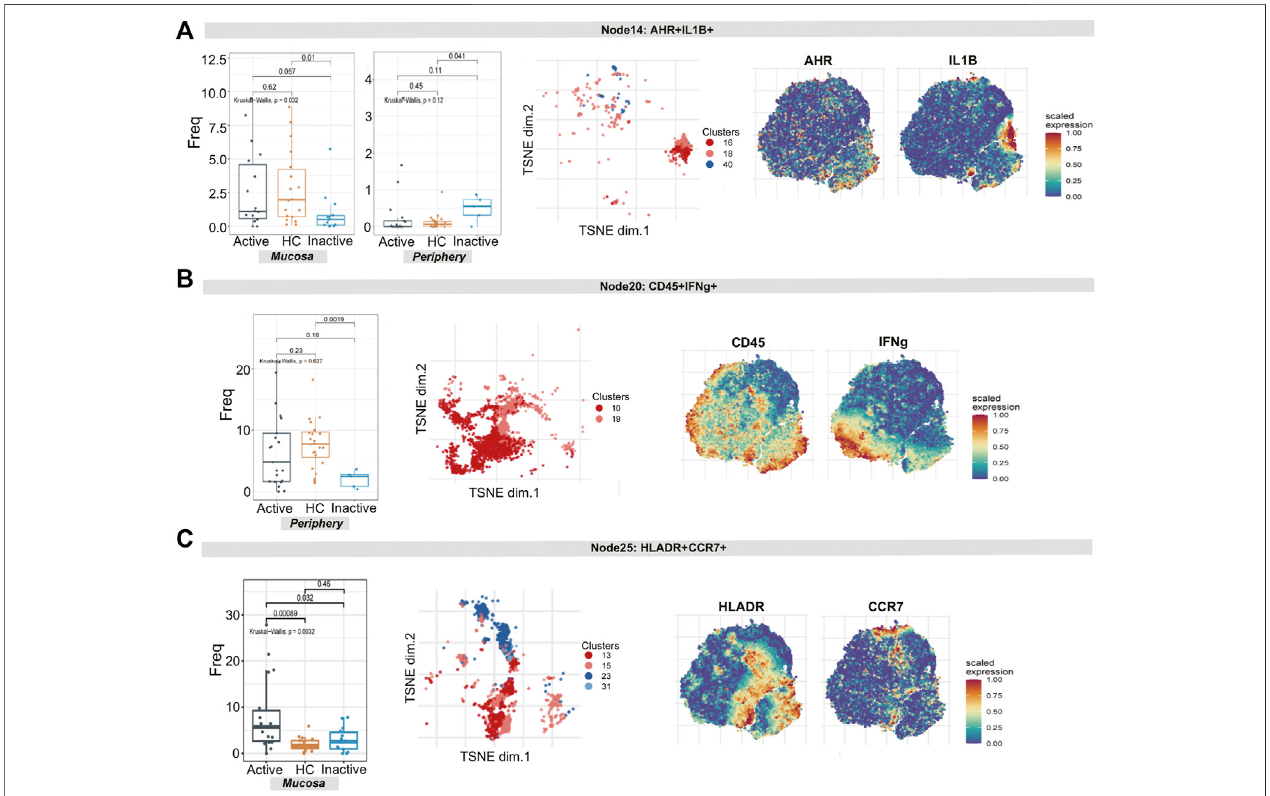
FIGURE5| CyTOFdemonstratesdifferentialinnatelymphoidcellanddendriticcellsignaturesinUCpatientsandHCs. (A – C) Abundanceboxplotsandt-SNEplots of node 14 (A) , node 17 (B) and node 18 (C) in innate immune cells, with respective selected marker heatmaps for reference.